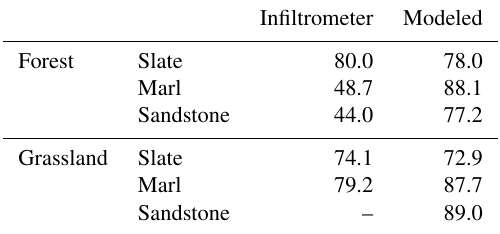
Table 5. Percentage of event with measured v max exceeding the infiltrometer ( K mat ) or modeled matrix flow velocities ( v mat